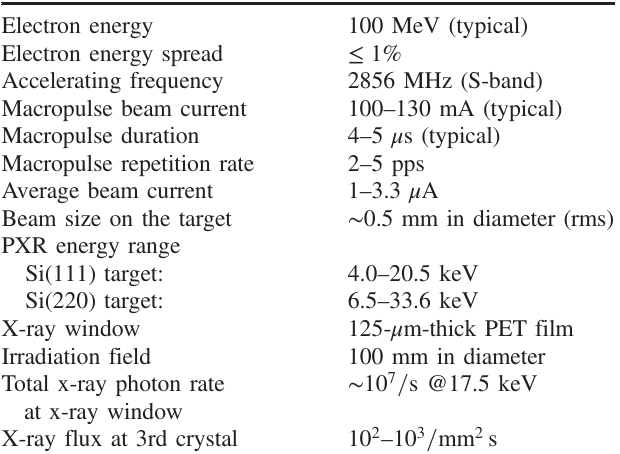
TABLE I. Parameters of the LEBRA linac and the PXR